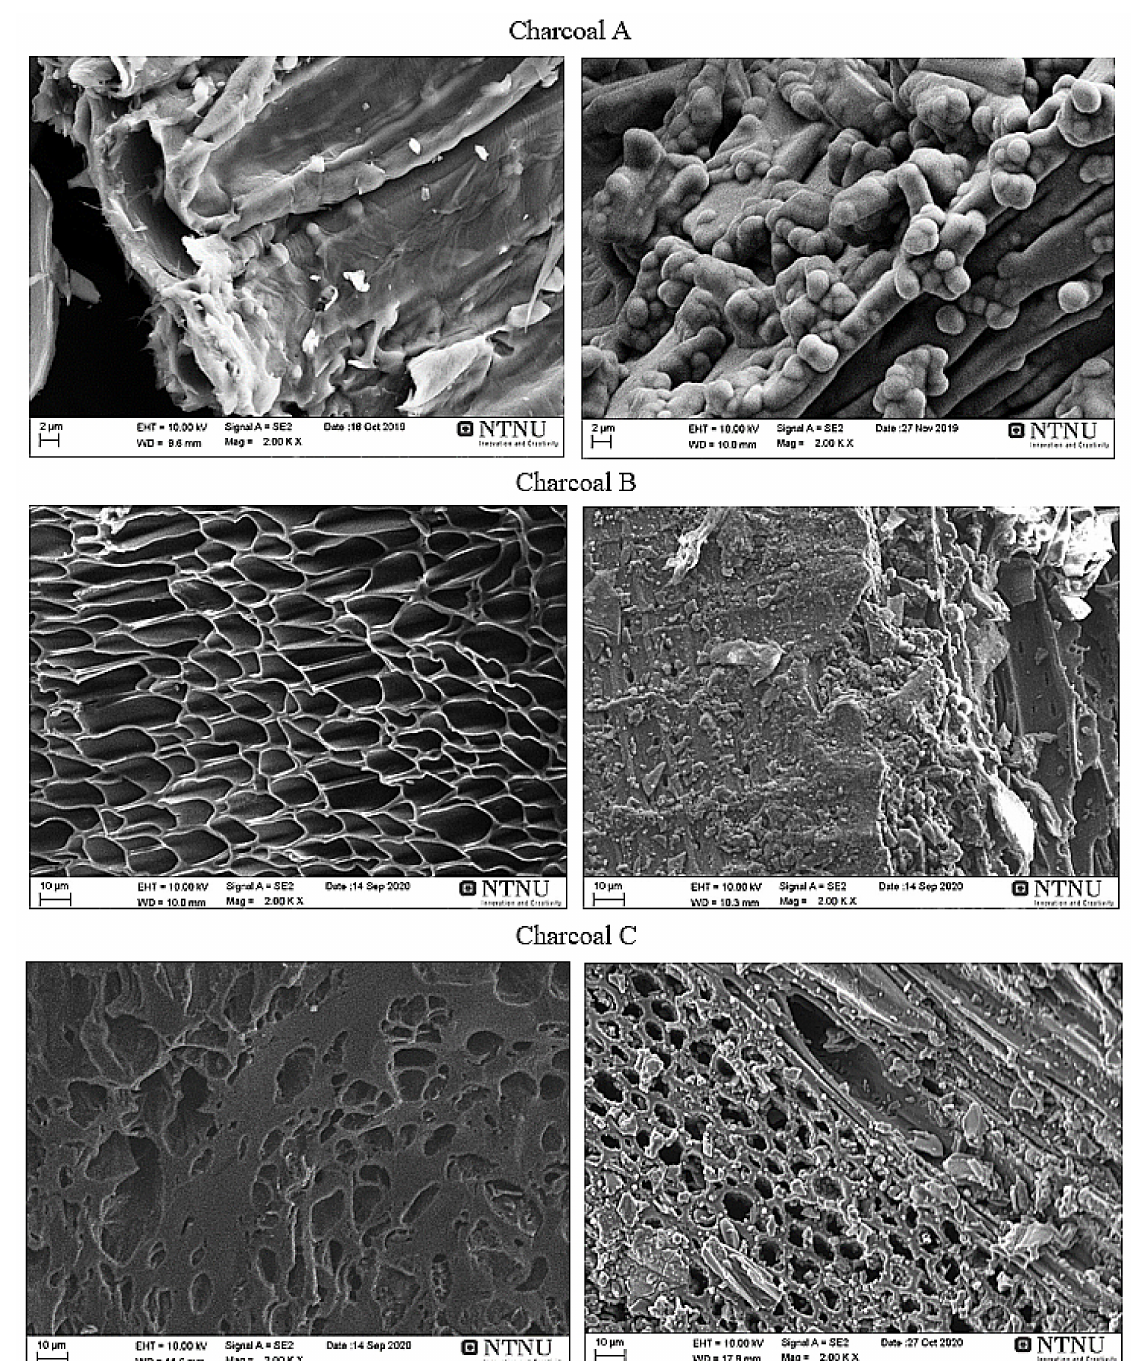
Figure 3. Scanning electron microscopy (SEM) images of raw (left) and densified (right) charcoals A, B and